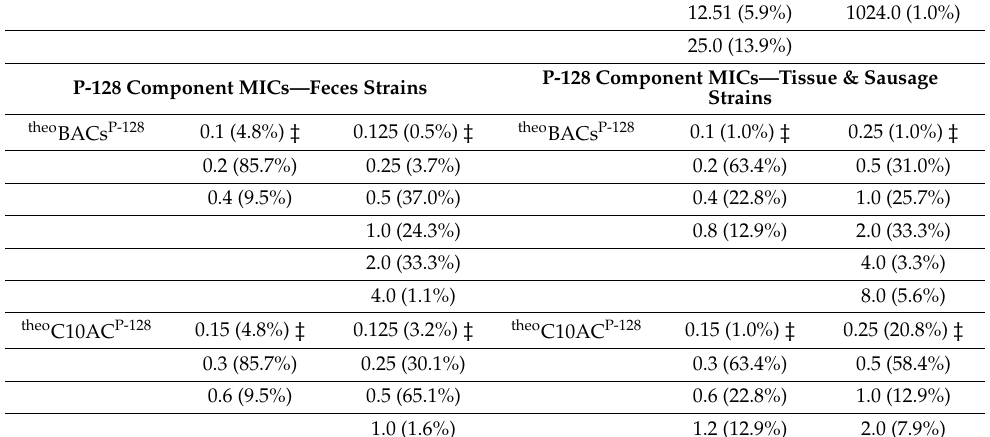
* Component MICs obtained from Table 4 for the BACs, (C12BAC, C14BAC, and C16BAC), Form (formaldehyde), THN (tris(hydroxylmethyl)nitromethane), and C10AC (didecyldimethylammonium chloride) against S. aureus strains from feces. † Component MICs obtained from Table 5 for the BACs, (C12BAC, C14BAC, and C16BAC), formaldehyde, THN (tris(hydroxylmethyl)nitromethane), and C10AC (didecyldimethylammonium chloride) against S. aureus strains from the MLT and PSM. ‡ Percentage of strains at the indicated